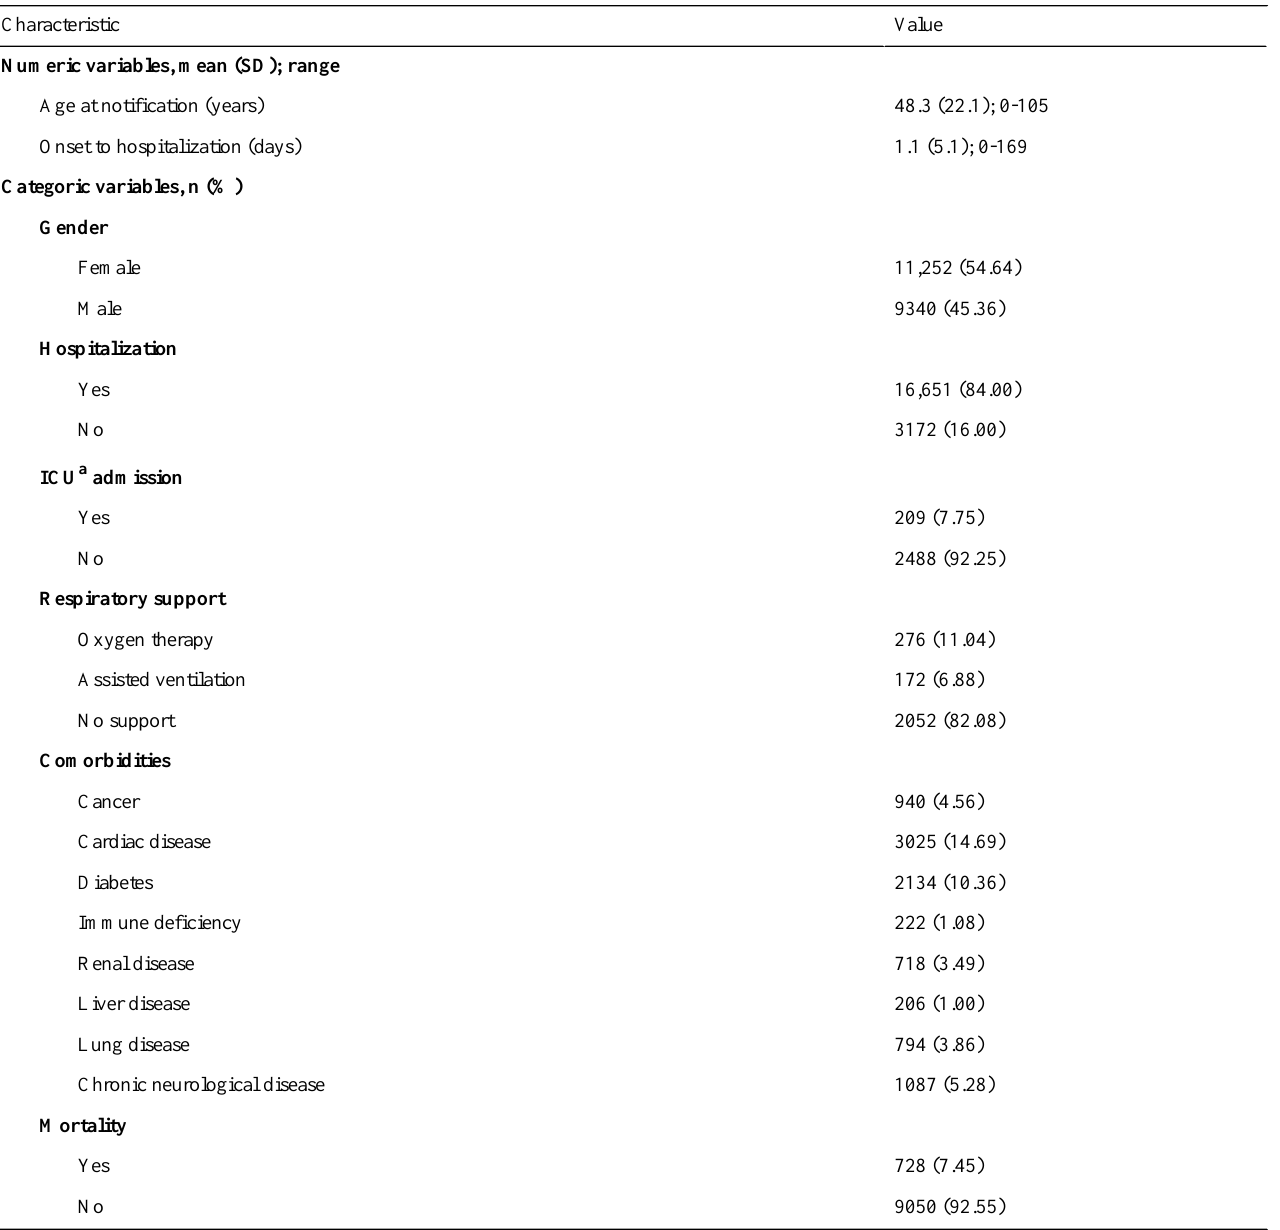
Table 1. Characteristics of SARS-CoV-2–infected patients in the target